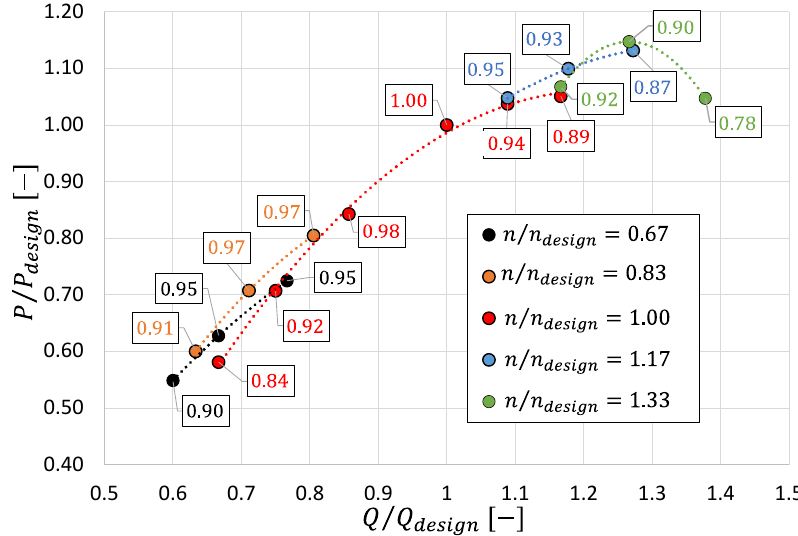
Figure 13. Normalized power curves versus the fraction of the design flow rate under the constant design net head. Numbers in the squares represent the normalized turbine hydraulic efficiency in agreement with Figure 12.